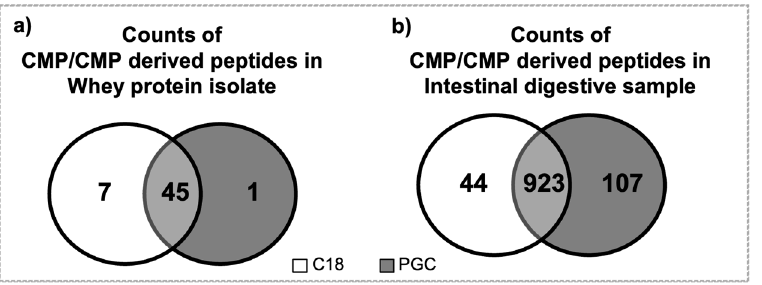
Figure 4. Venn diagrams for counts of CMP and CMP-derived peptides found in the C18 (white) and PGC (grey) elution fractions of ( a ) whey protein isolate and ( b ) the intestinal digestive samples.